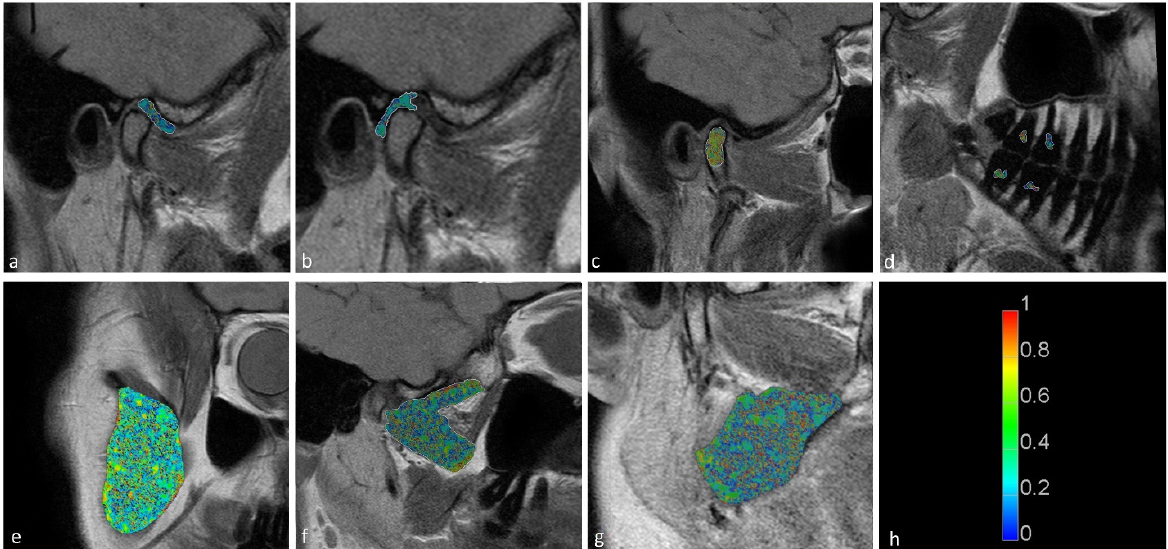
Figure 5. Long fraction components for the ( a ) disk; ( b ) retrodiscal tissue; ( c ) bone marrow of the condyloid process; ( d ) pulp; ( e ) m. masseter; ( f ) m. pterygoideus lateralis; and ( g ) m. pterygoideus medialis. ( h ) Color scale showing the reference values.